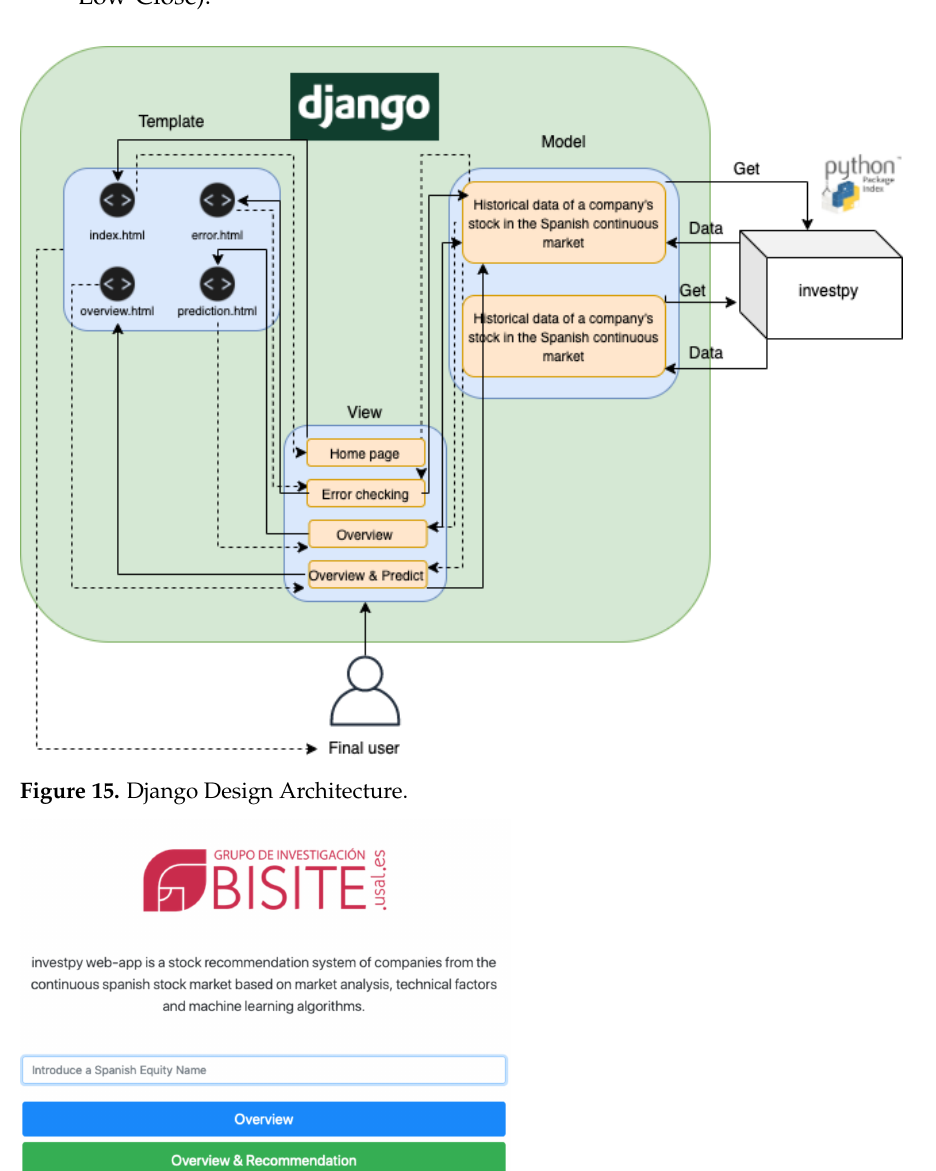
Figure 16. Main view of the web